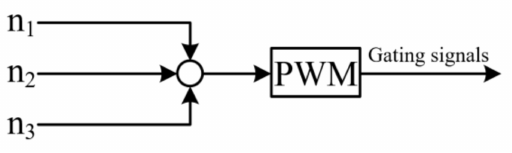
Figure 8. Switching signals